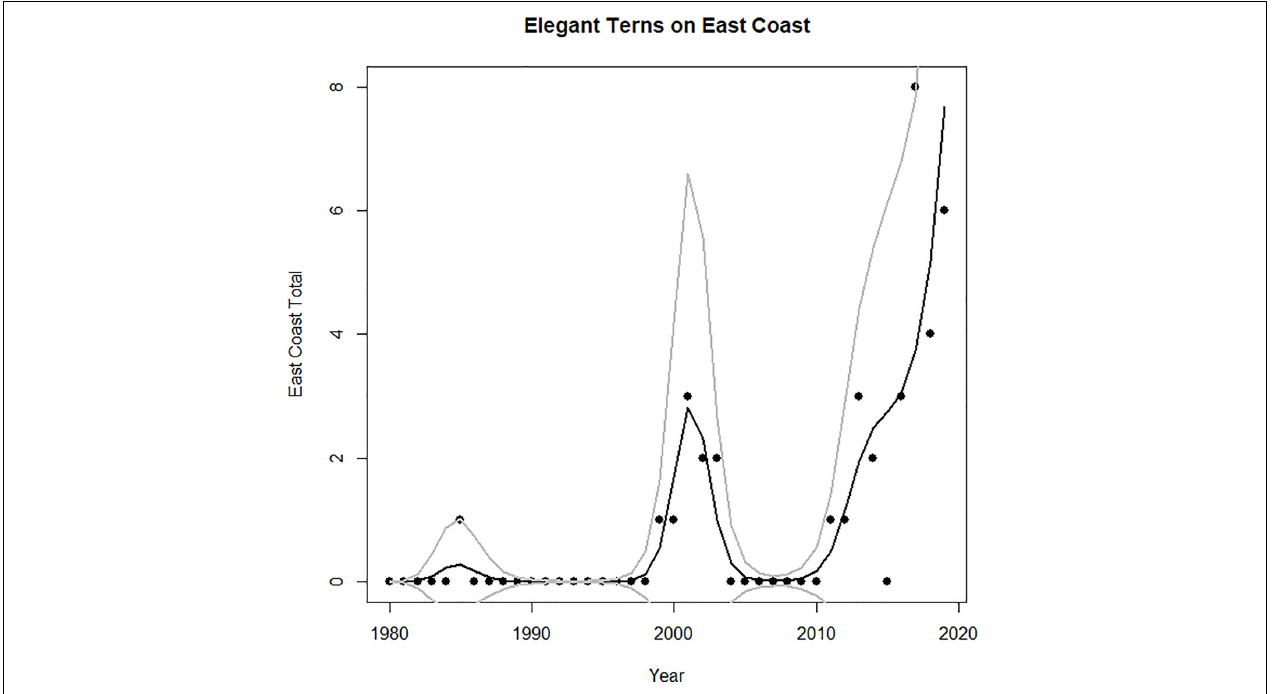
FIGURE 4 | Time series of abundance of vagrant elegant terns to east coast of North America (Massachusetts to Florida). Predicted values and confidence intervals